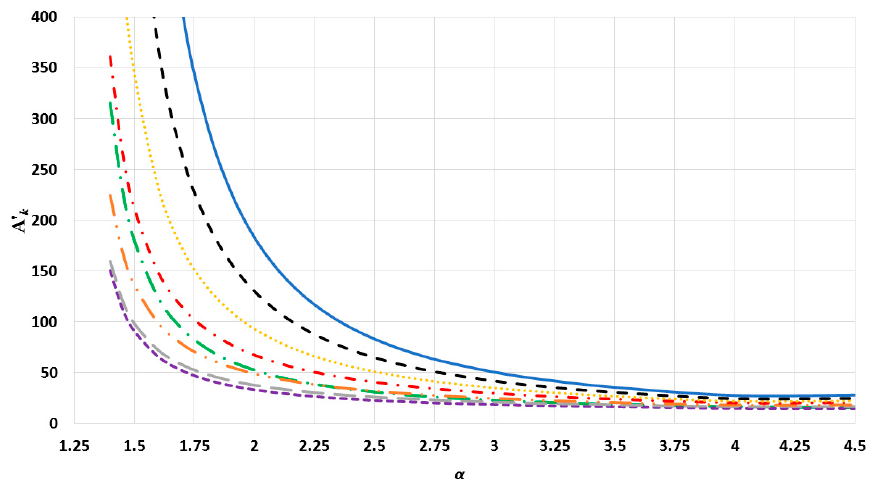
Figure 4. The variation of (cid:1827)′ (cid:3038) ((cid:1870) (cid:2868)∗ ) for a face-centered cubic metal with the (cid:2009) parameter for (cid:1865) = 4 , where the blue solid line represents (cid:1827)′ (cid:2876) ((cid:1870) (cid:2868)∗ ) , the black medium dashed line represents (cid:1827)′ (cid:2875) ((cid:1870) (cid:2868)∗ ) , the yellow dotted line represents (cid:1827)′ (cid:2874) ((cid:1870) (cid:2868)∗ ) , the red dashed-dotted line represents (cid:1827)′ (cid:2873) ((cid:1870) (cid:2868)∗ ) , the orange dashed-dotted-dotted line represents (cid:1827)′ (cid:2872) ((cid:1870) (cid:2868)∗ ) , the gray long-dashed line represents (cid:1827)′ (cid:2871) ((cid:1870) (cid:2868)∗ ) , the purple short-dashed line represents (cid:1827)′ (cid:2870) ((cid:1870) (cid:2868)∗ ) , and the green long-dashed-dotted line represents (cid:1827)′ (cid:2869) ( (cid:1870) (cid:2868)∗ ) .